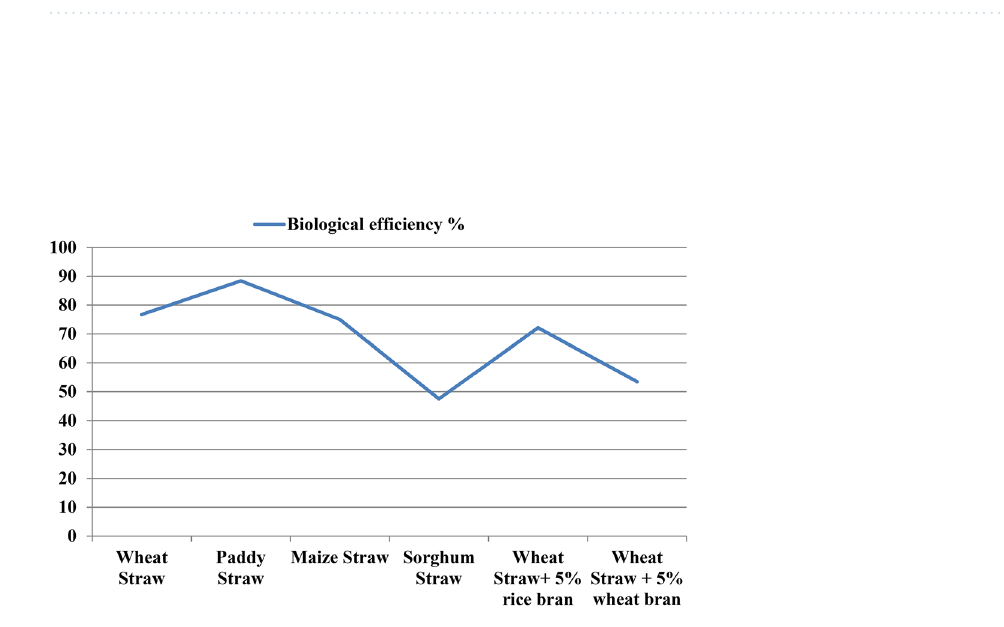
Figure 3. BE% obtained from different substrates and